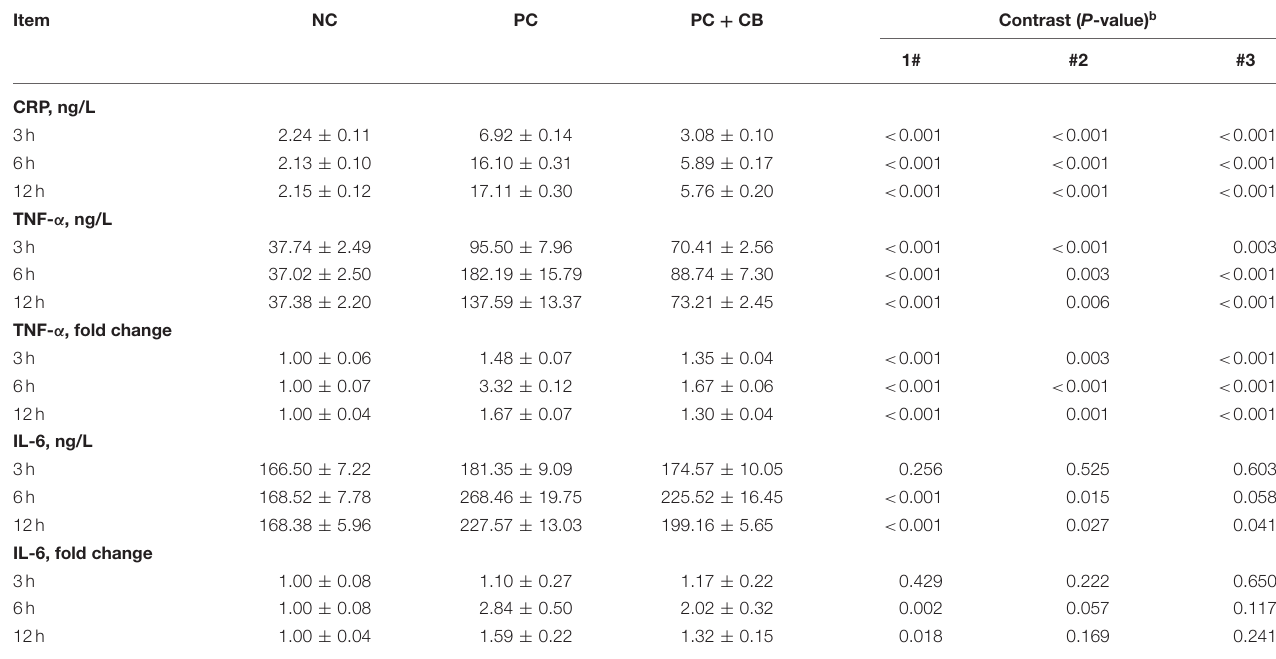
TABLE 3 | Effect of CB on immune status in ETEC K88-infected piglets a .